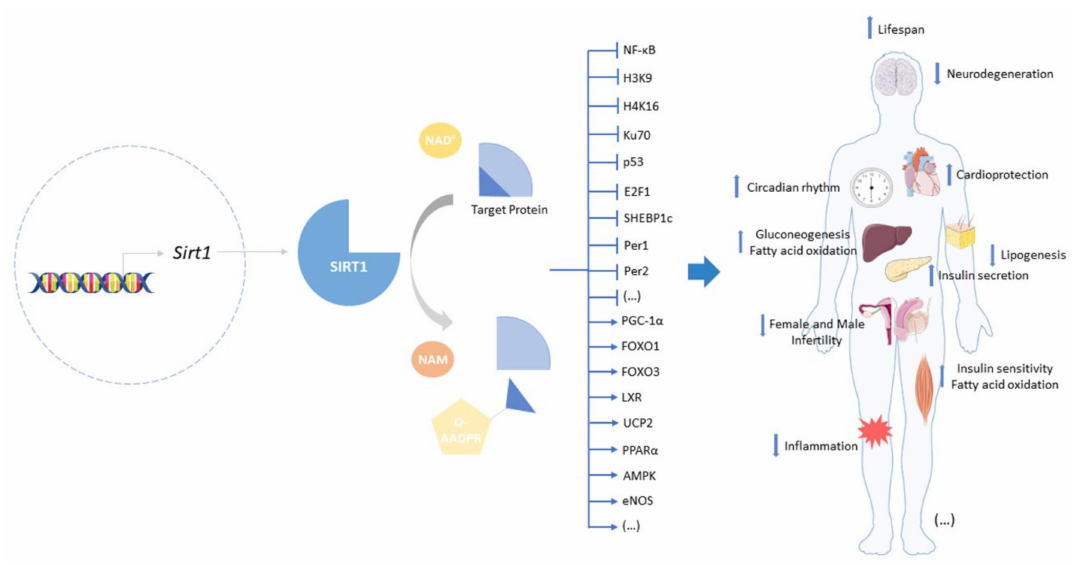
Figure 1. Deacetylation reaction, targets, and physiological consequences of SIRT1 activation. SIRT1 catalyzes the deacetylation of histone and non-histone target proteins by breaking the bonds between NAD + and niacinamide, transferring the acetyl group from proteins to ADP-ribose, and re- leasing the deacetylated protein. Deacetylation can inhibit ( ꓕ ) or activate ( ↓ ) the target protein that will result in beneficial effects, such as longevity extension, neuroprotection, and cardioprotec-